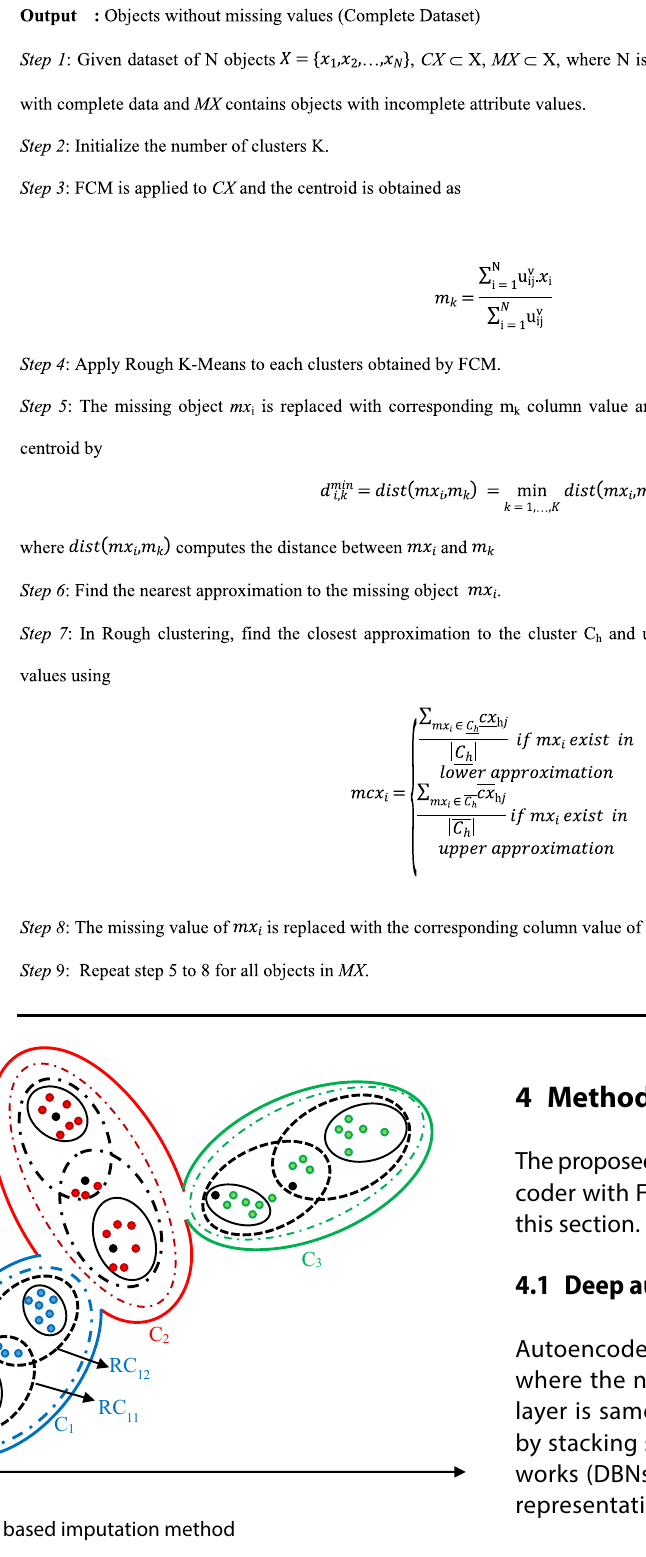
Fig. 2 FCMRP based imputation